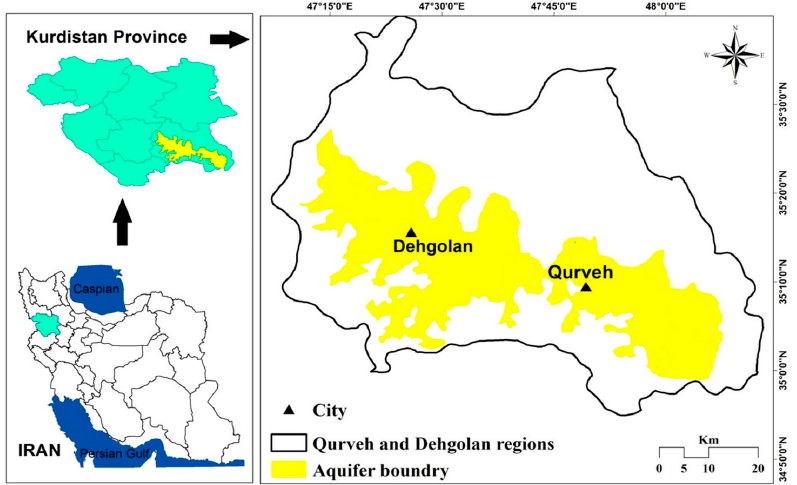
Figure 1. Geological map of the a ff ected area (Adapted with permission from